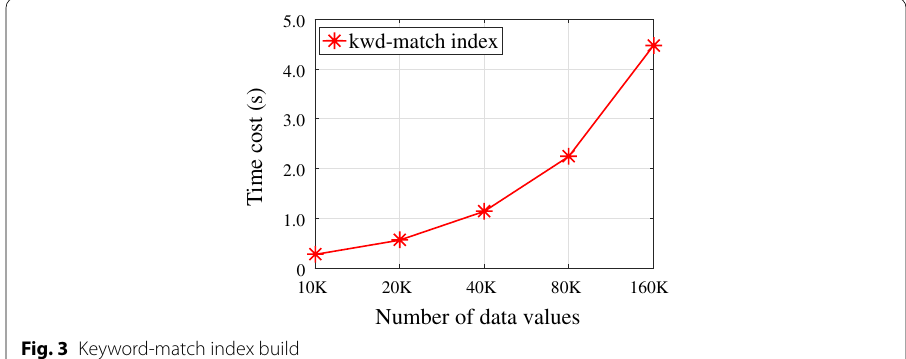
Fig. 3 Keyword-match index build